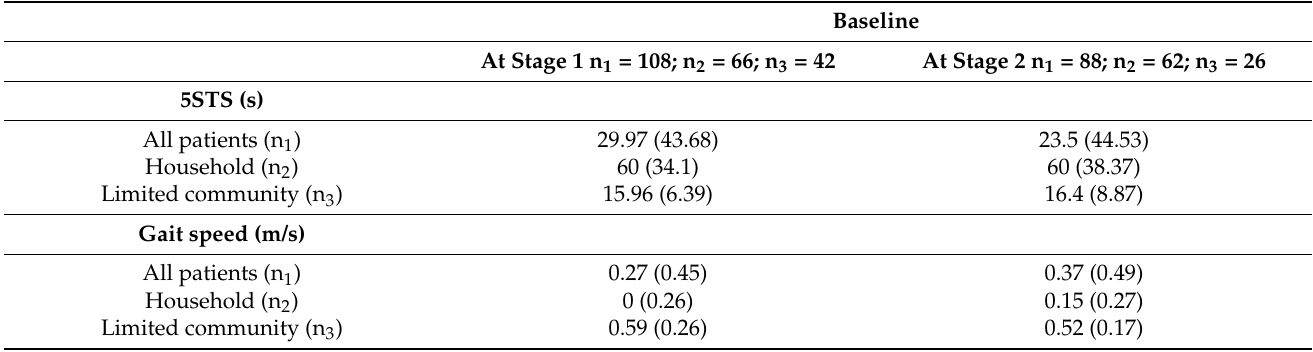
Table 2. Medians (interquartile range) of the 5STS time and gait speed at baseline in all patients and by walking category.